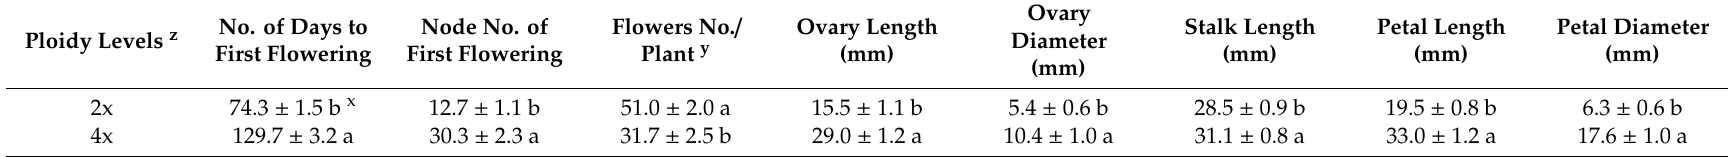
Ploidy Levels z